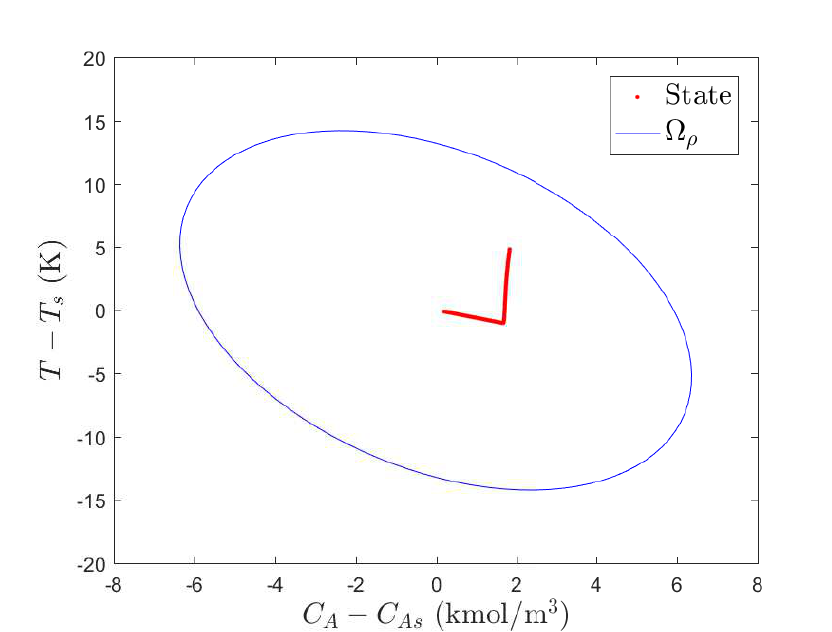
Figure 9. State-space plot when no cyberattack is performed for the methyl isocyanate hydrolysis process. Data was plotted every 1000 integration steps (i.e., every 10 − 3 s).